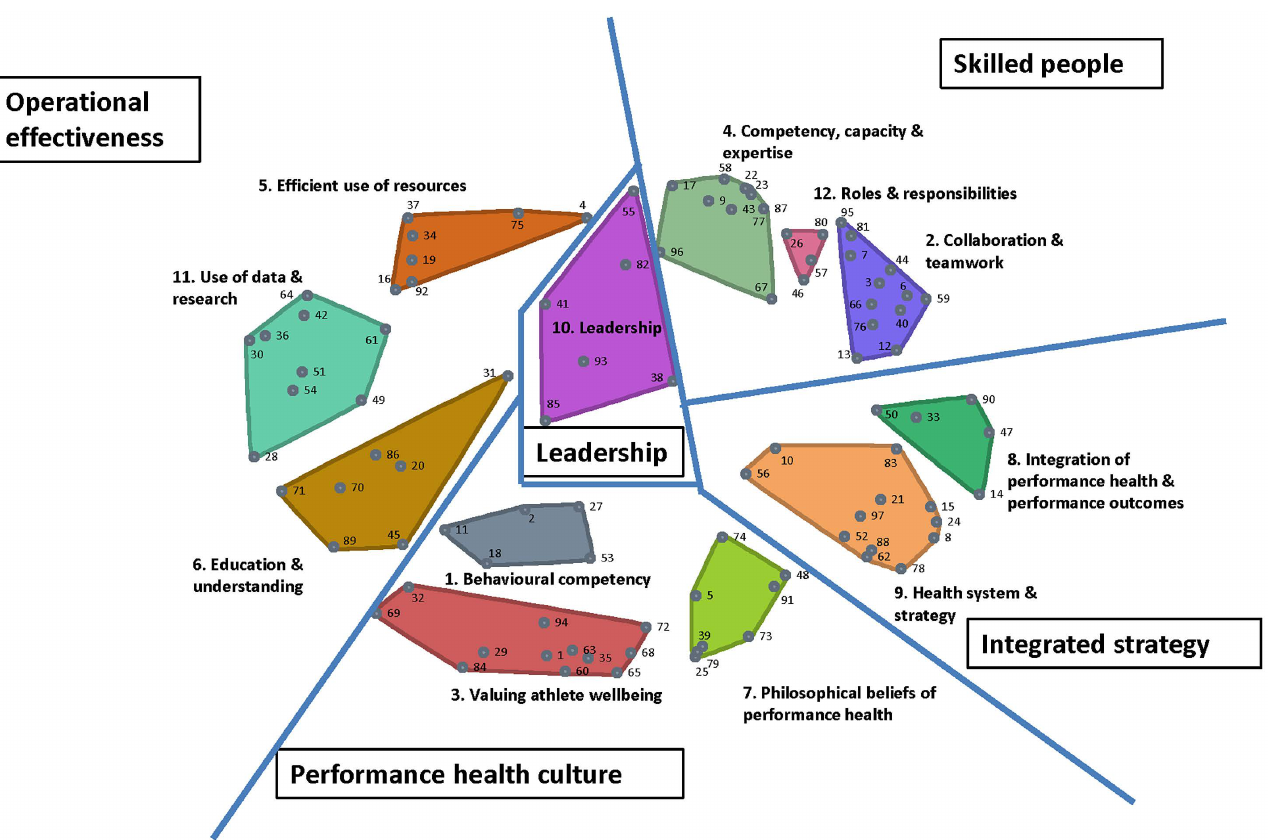
Figure 1. Five-domain, 12-cluster map of ideas from members of the high-performance sport system for achieving athlete performance